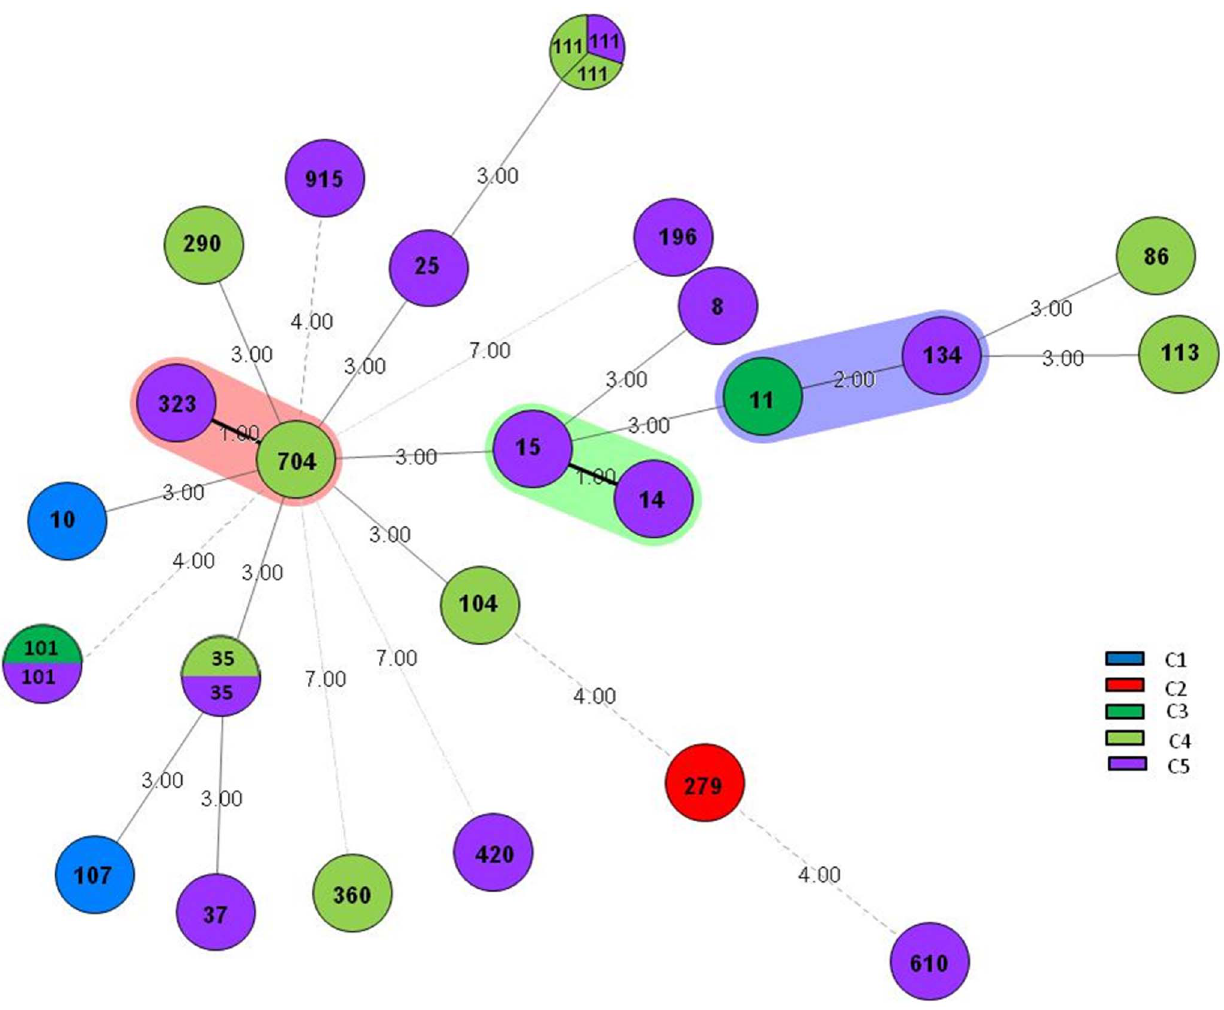
Figure 2. Mean spectra projection (MSP) dendrogram of Klebsiellapneumoniae strains generated by BIOTYPER software (version 2; Bruker Daltonics). ESBL: Extended-spectrum beta-lactamase, WT: wild type.